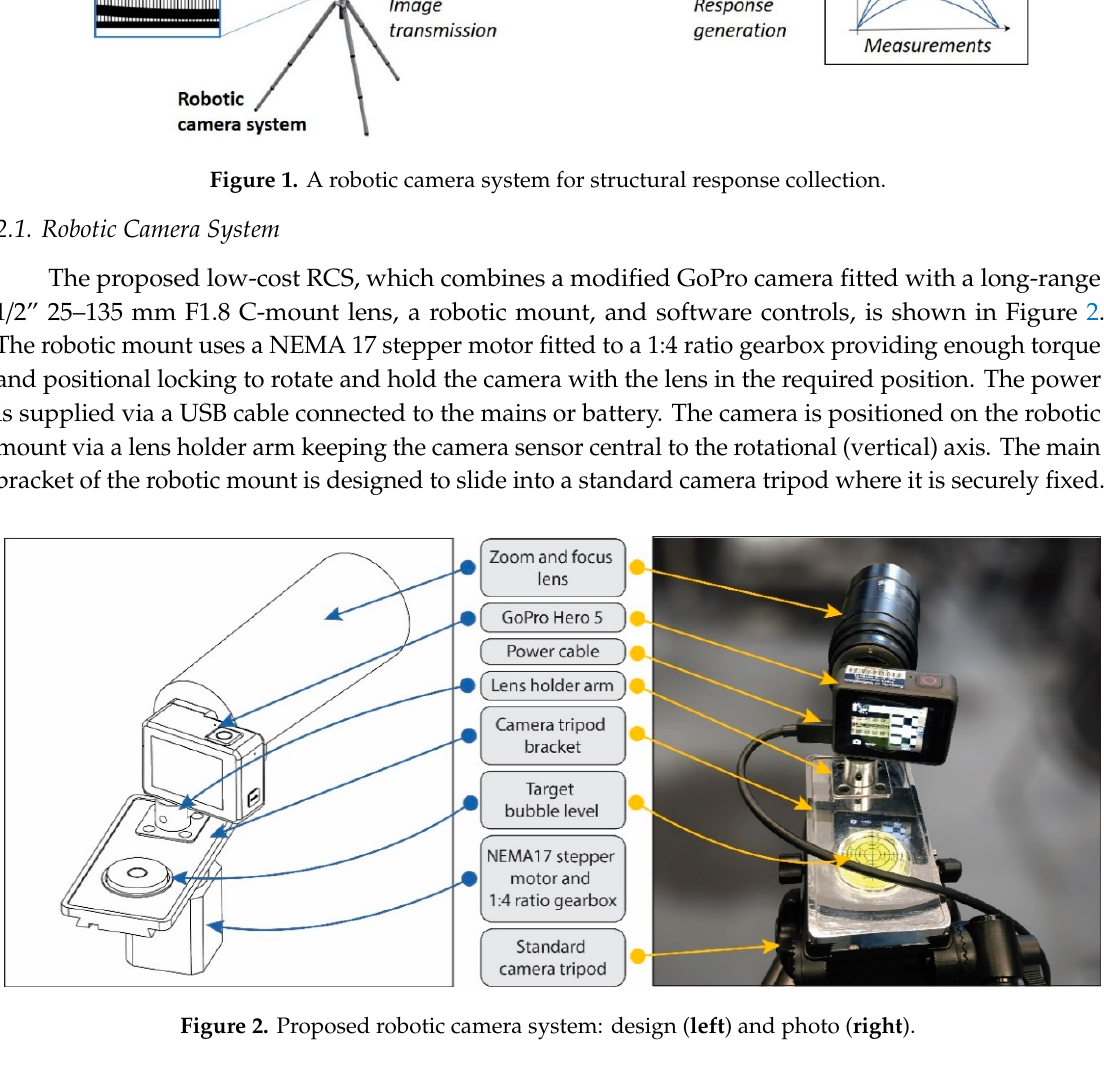
Figure 1. A robotic camera system for structural response collection.